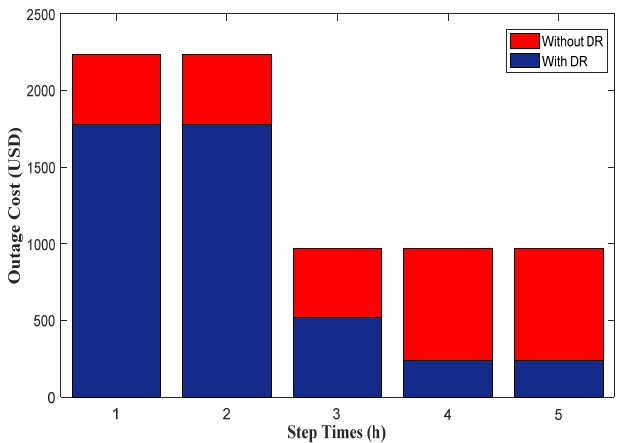
Figure 7. The e ff ect of EDRP on the outage cost in the 34 bus Figure 7. The effect of EDRP on the outage cost in the 34 bus case.